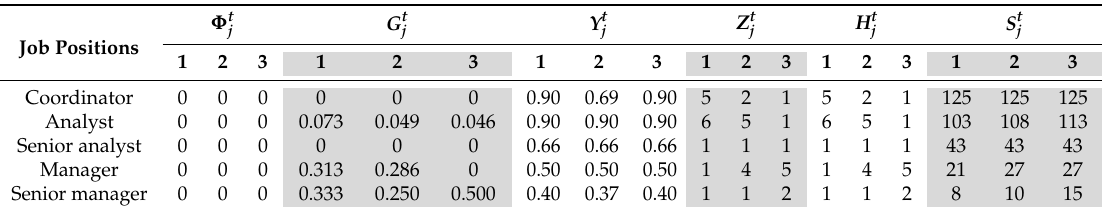
, H t and S t in three time j j j